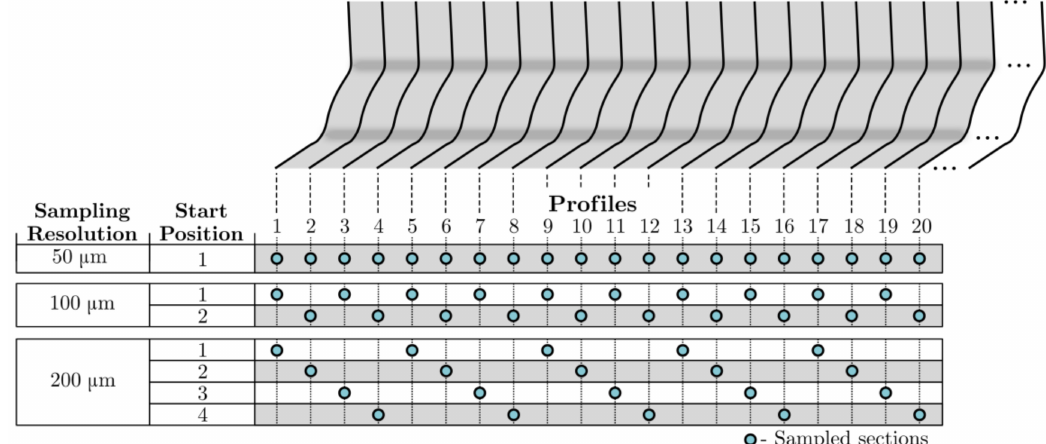
Figure 13. Resampling of scanning data by excluding weld profiles. Each row represents a sampled sequence including only the profiles with filled